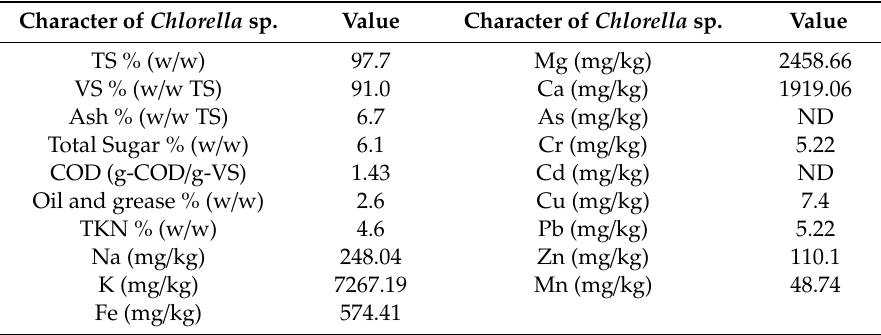
Table 2. Characterizations of the Chlorella